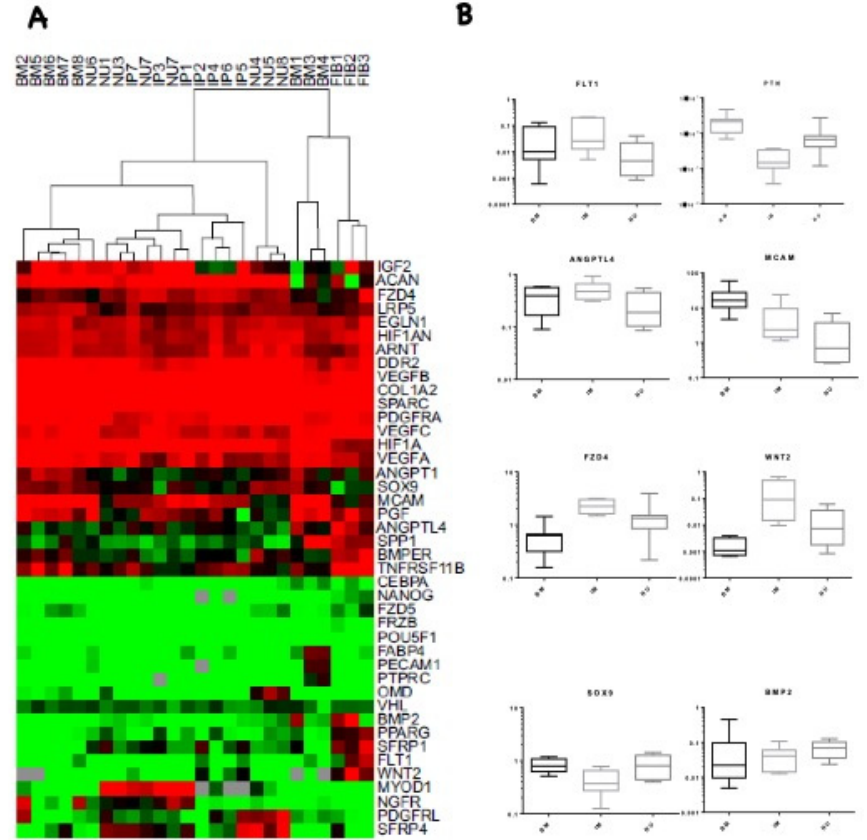
Figure 4. Di ff erentially expressed transcripts in MSCs derived from IP and NU tissue. Cluster analysis of log 2 transformed relative expression data: 2 − ∆ Ct normalised to HPRT. IP—induced periosteum ( n = 7), NU—non-union ( n = 8), BM—bone marrow ( n = 8), and Fib—skin fibroblasts negative control ( n = 3). Green < HPRT, red > HPRT, black = HPRT, and grey is missing data. Genes were analysed when 80% present, complete linkage clustering was performed and viewed using Java Treeview ( A ). Genes showing marked di ff erences in relative expression between NU MSCs and IP MSCs; BM MSCs included as controls. Genes involved in regulation of endothelial cells ( FLT1, PTN, ANGPL4 , and MCAM ), Wnt signalling genes ( FZD4 and WNT2 ), and genes involved in MSC di ff erentiation ( SOX9 and BMP-2 ) ( B ). All data IP ( n = 7), NU ( n = 8), BM ( n = 8). R.E.U.—relative expression unit.